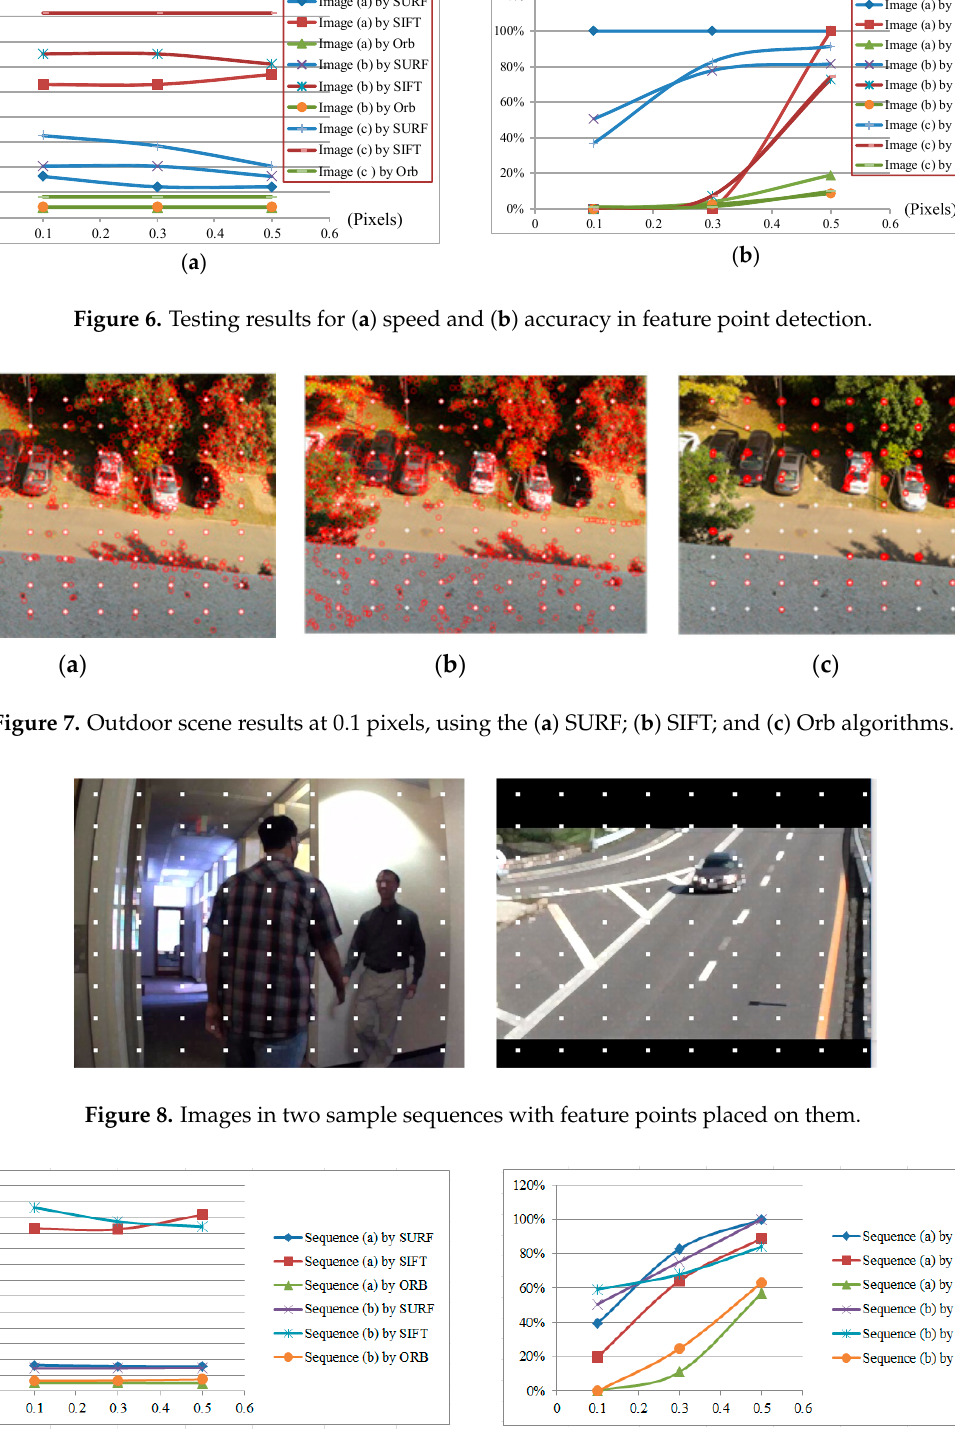
Figure 9. Sequence testing results for ( a ) speed and ( b ) accuracy.